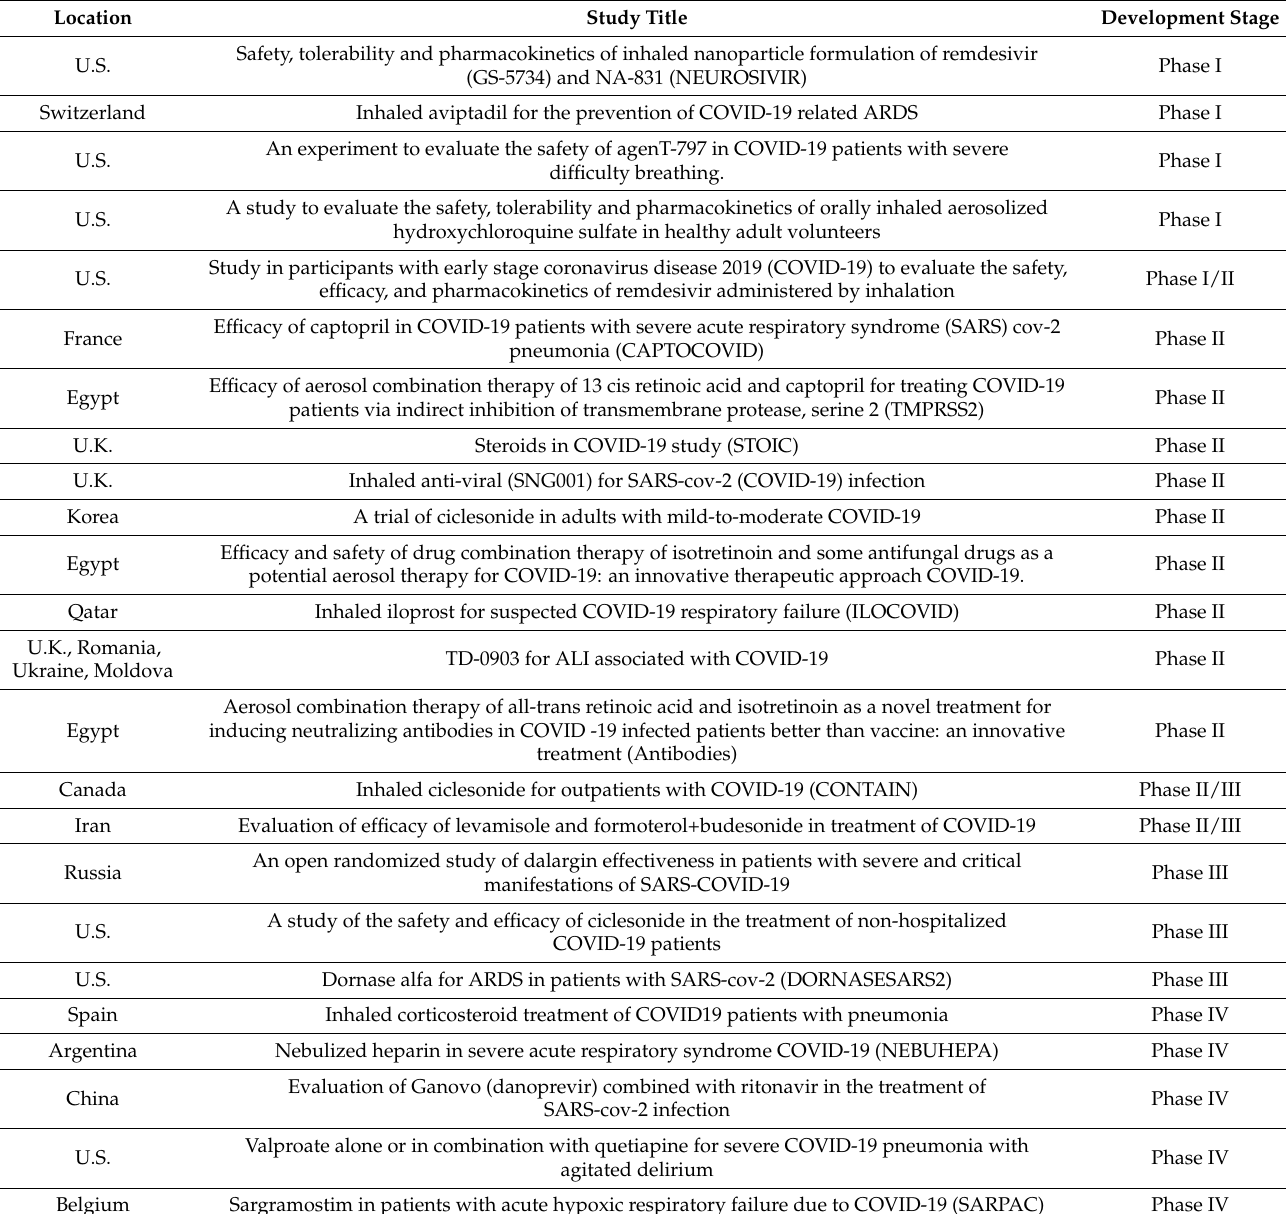
Table 1. Ongoing clinical trials of new and repurposed inhaled drugs in COVID-19 (ClinicalTrials.gov, accessed Oct. 2020, not intended to be